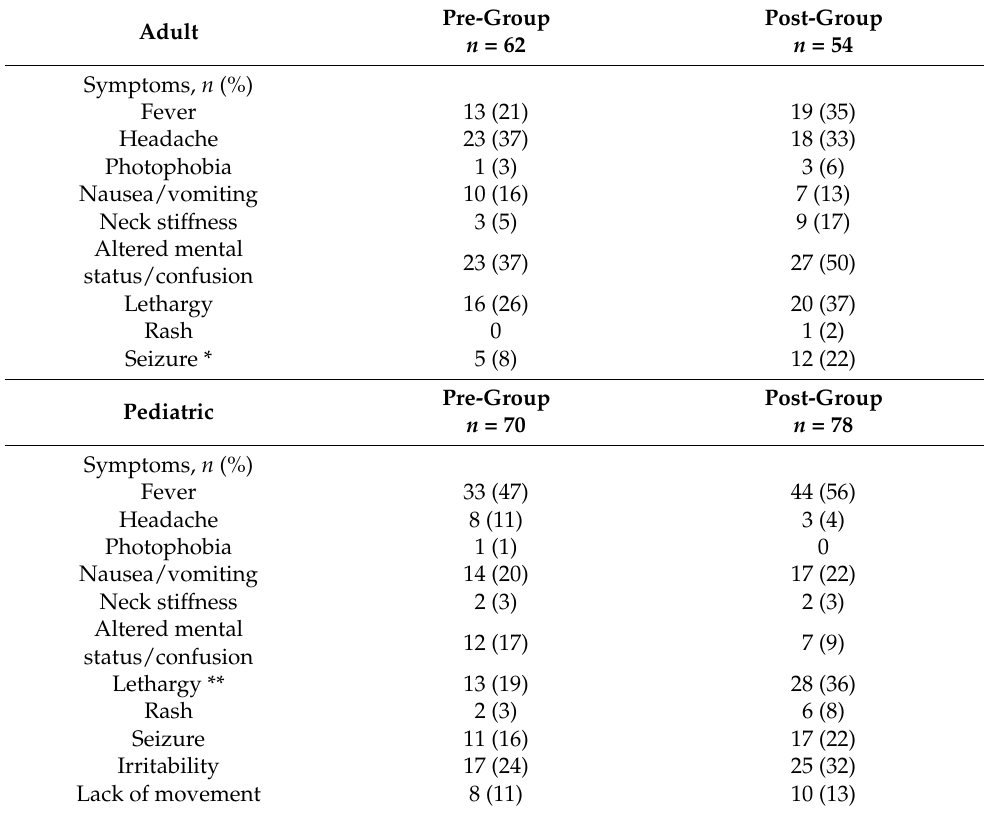
Table 2. Symptoms of meningitis/encephalitis among patients included in the pre- and post-groups at admission and divided by adult and pediatric patients. Adult